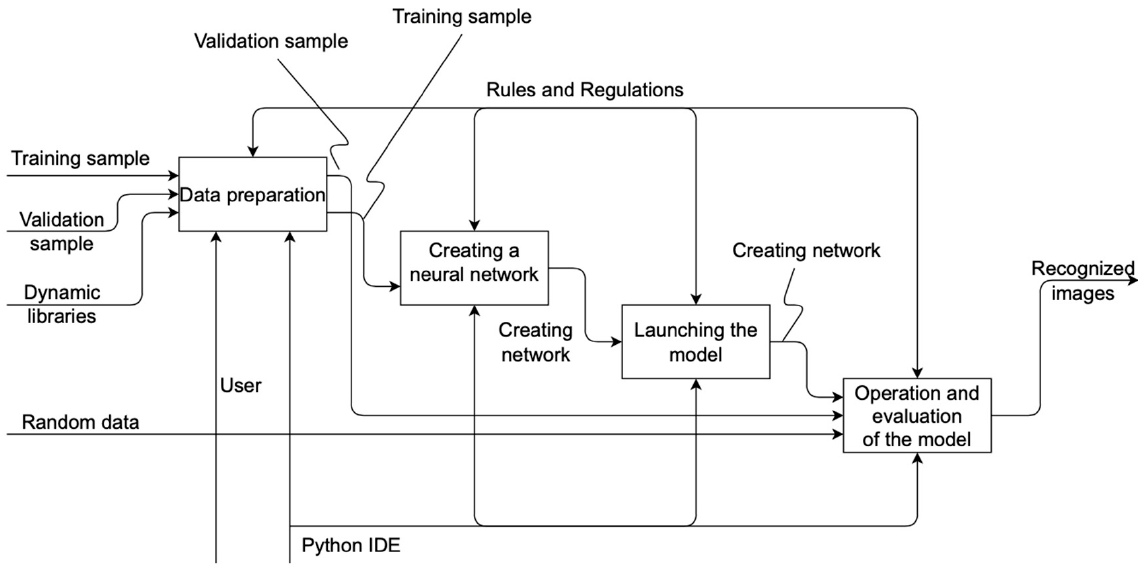
Figure 2. Decomposition of the context diagram.